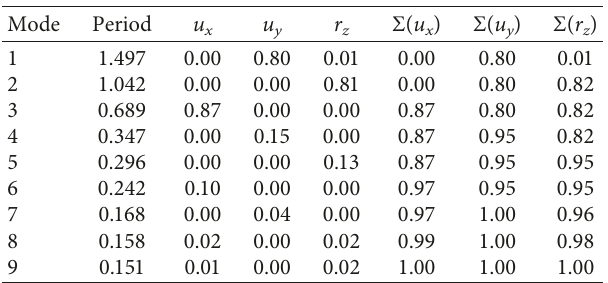
Table 3: Results of the modal analysis.